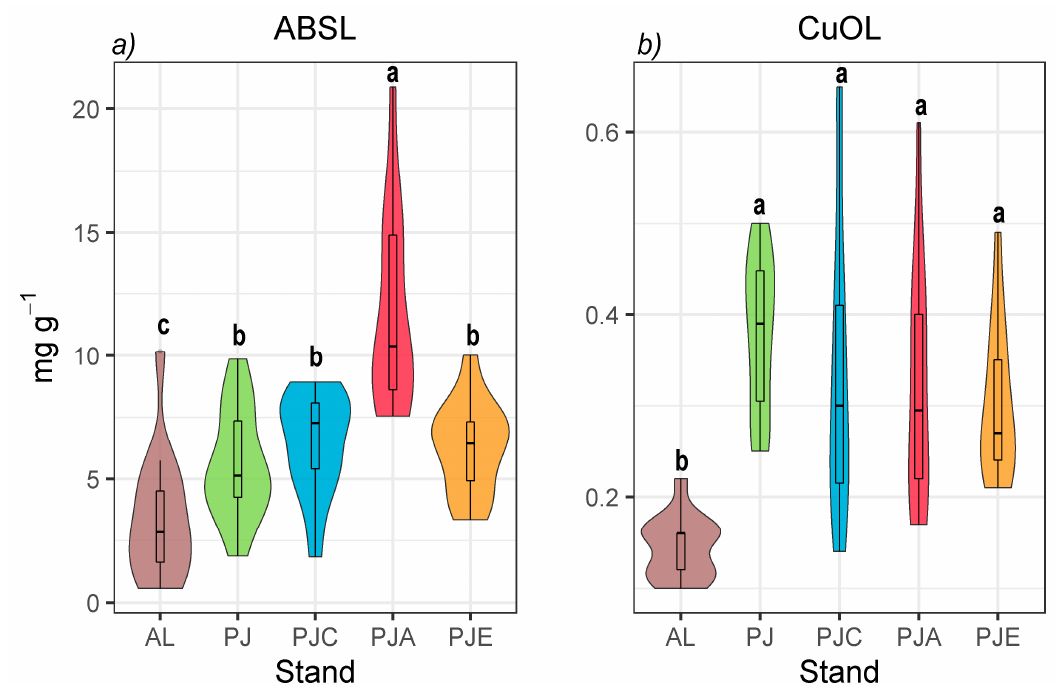
Figure 1. ( a ) Acetyl-bromide spectrophotometric lignin (ABSL) and ( b ) CuO oxidation lignin (CuOL) (as the sum of the V+S+C components of the CuO oxidation method) contents in the afforested stands and agricultural land. Data are represented as violin plots with a nested boxplot. Violin plots that do not share at least one letter are significantly different ( p ≤ 0.05 , Tukey’s post-hoc test follows one-way ANOVA).